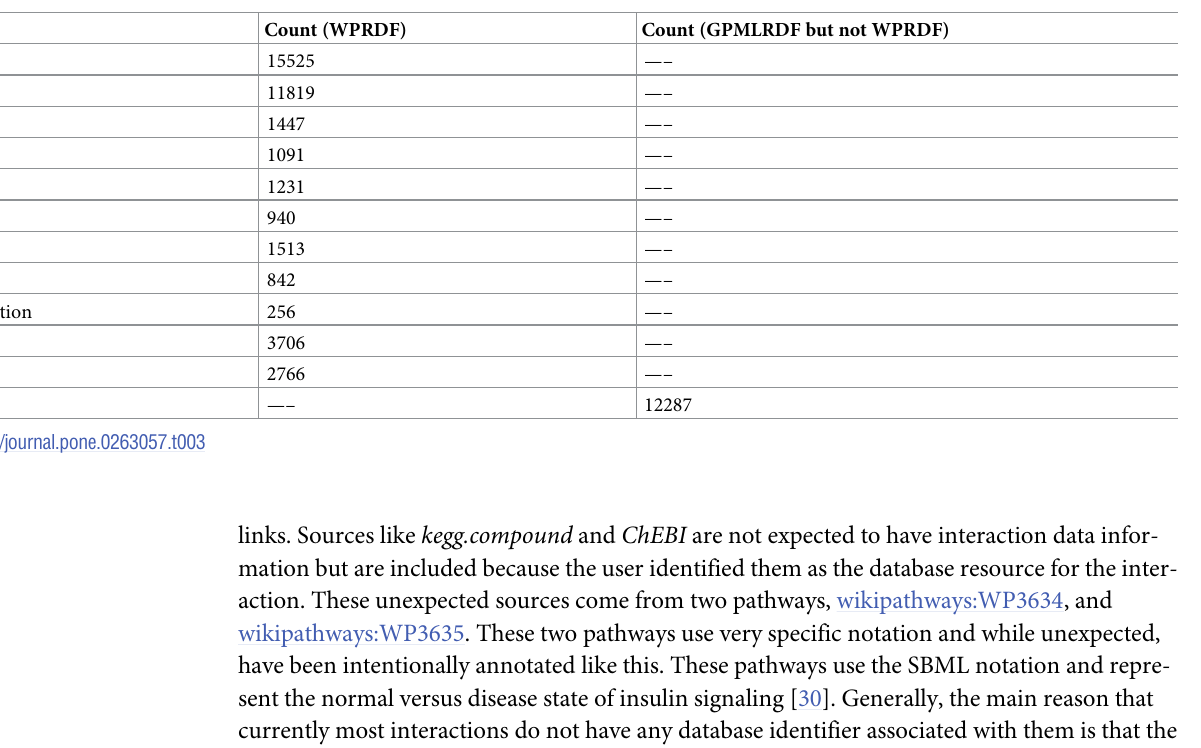
Table 3. Interaction type counts, as defined in the WikiPathways ontology. The sum of DirectedInteration and NonDirected equals the Interaction Total. Of the directed interactions, subsets are typed as Conversion, Inhibition, etc. The NonSpecified interactions is a subset of NonDirected interactions. More than 12 thousand inter- actions are only found in the GPMLRDF.